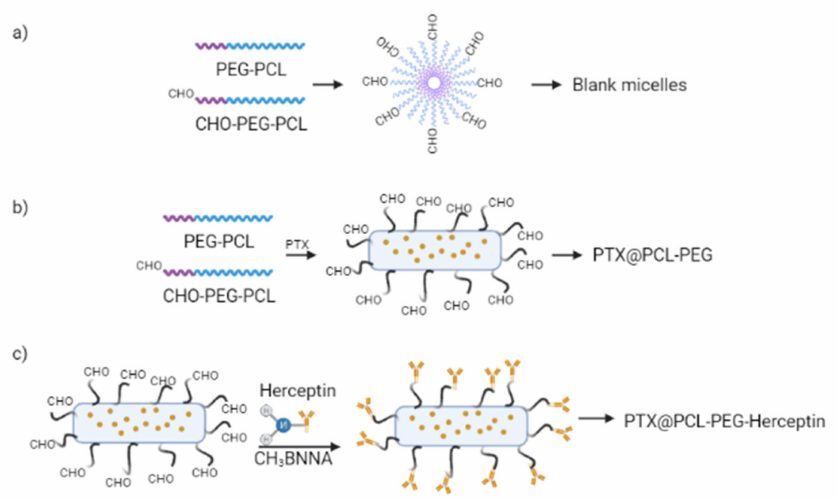
Figure 5. The formulation strategy of ( a ) Blank micelles, ( b ) PTX/CL-PEG, and ( c ) PTX/PCL-PEG- Herceptin. Reprinted/adapted with permission from Elsevier